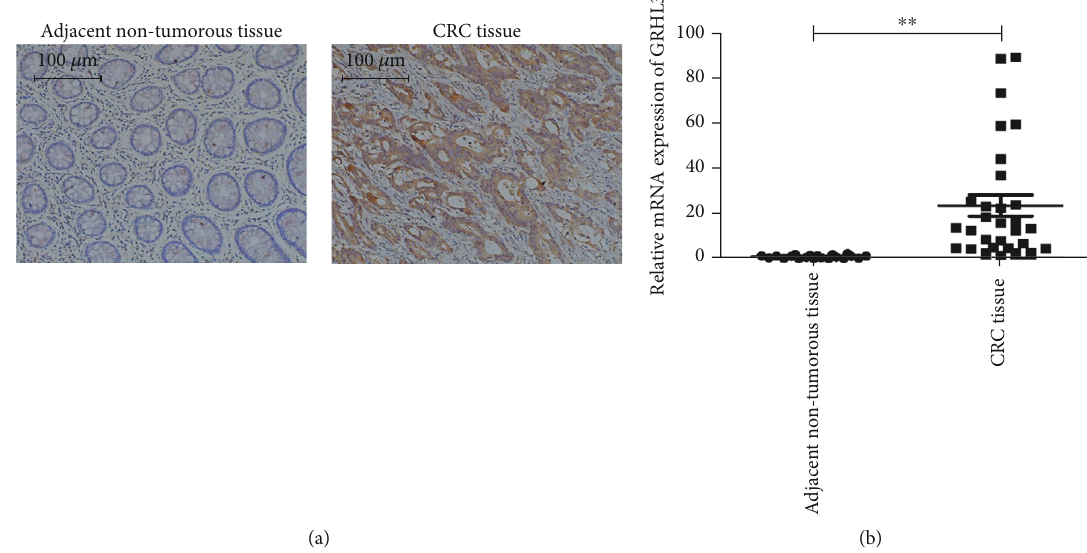
Figure 1: Protein and mRNA expression of GRHL3 was analyzed in CRC. (a) Immunostaining of the CRC tumor and the adjacent nontumorous tissue. (b) qPCR analysis of the mRNA expression of GRHL3 in the tumor ( n = 30 ) and the adjacent nontumorous tissue ( n = 20 ) from CRC patients and β -actin as the loading control. Data are presented as mean ± SEM . ∗∗ P < 0 : 01 vs. the adjacent nontumorous